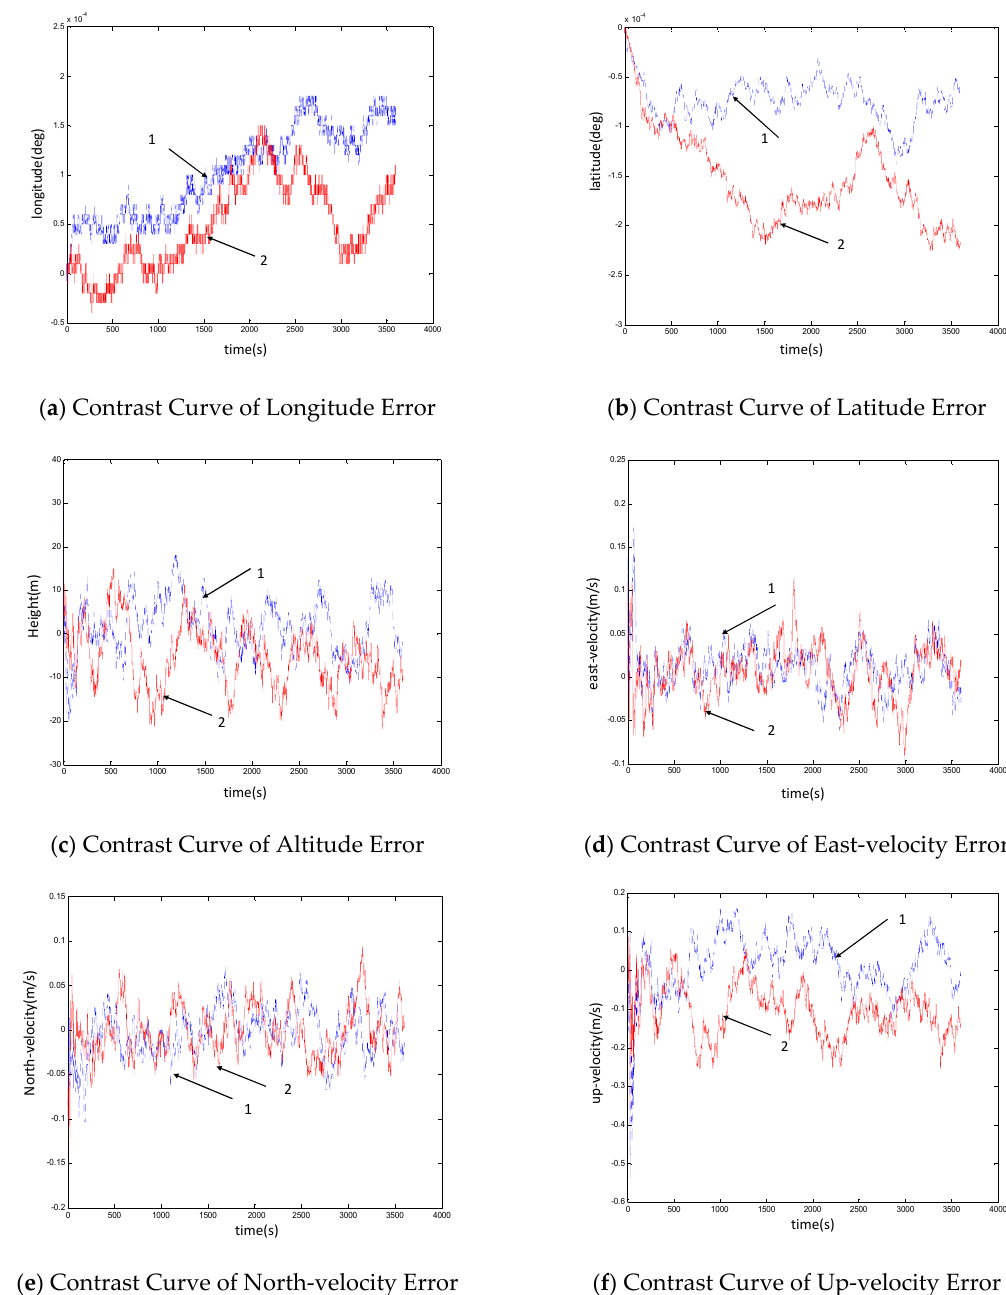
Figure 5. Contrast Diagram of System Self-regulation Fusion Navigation Results When the Optical Flow Sensor Fails.